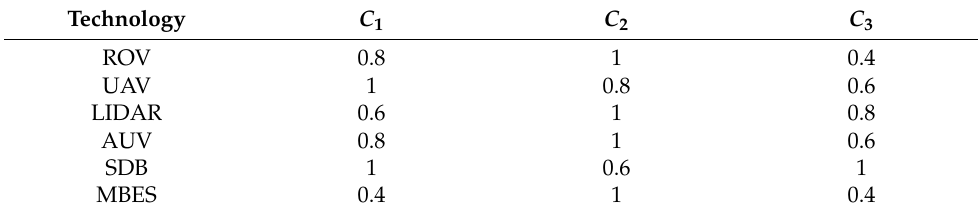
Table 7. The normalized decision matrix.